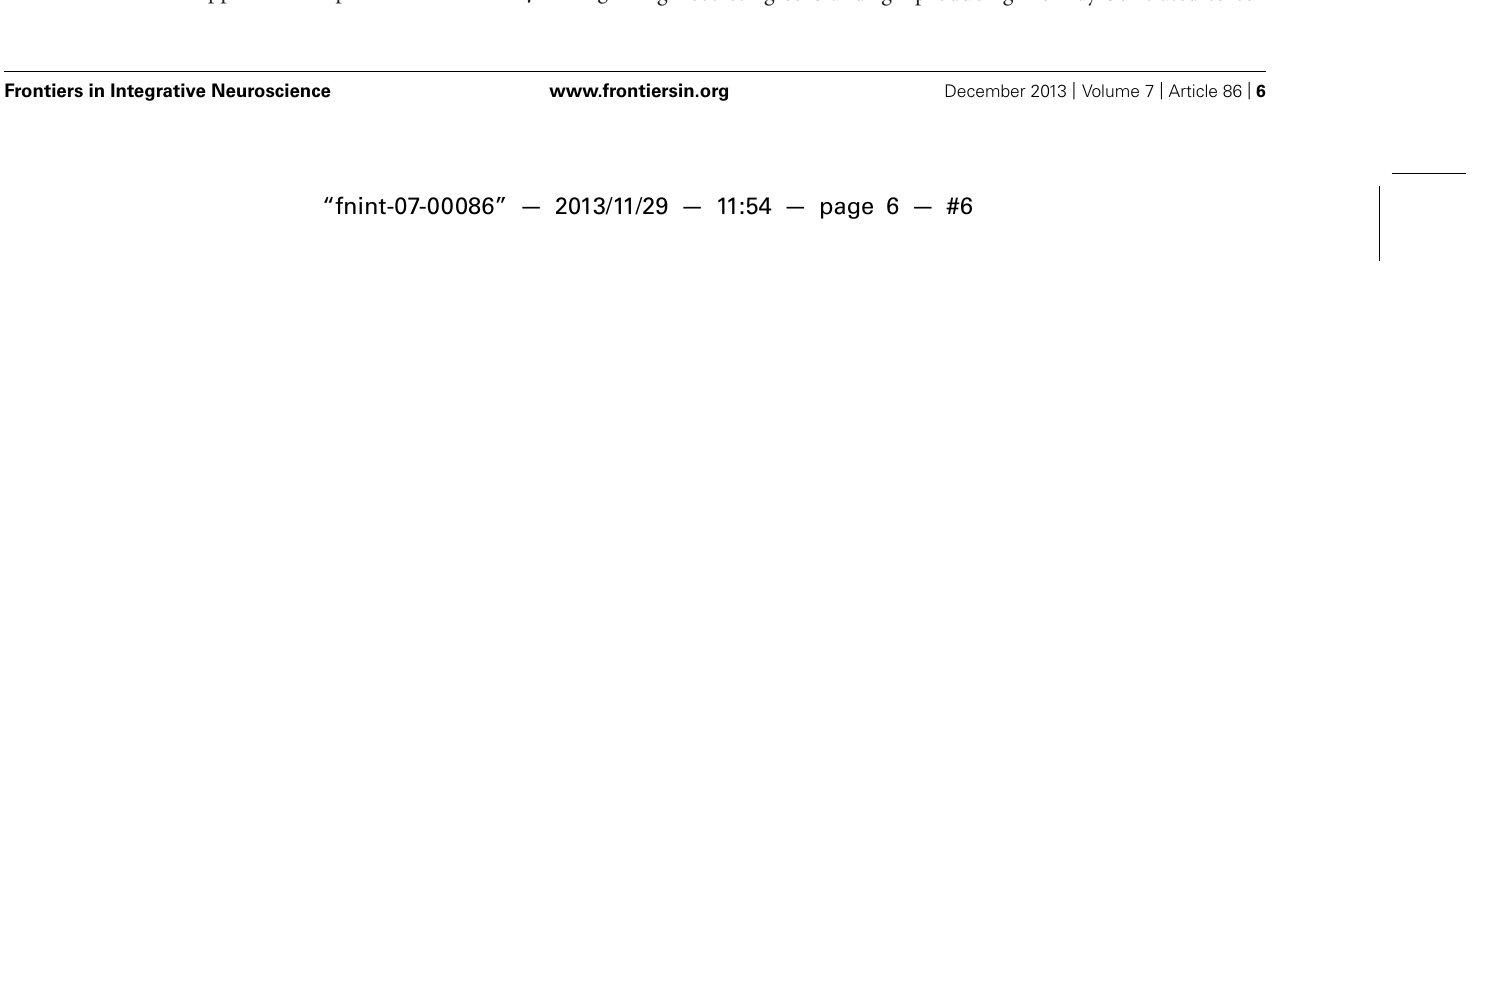
The former is then released to the gut lumen as secretory component (SC) bound to dIgA to yield secretory IgA (SIgA). SIgA and SC secreted into the mucus layer prevent the direct adhesion to the epithelium of pathogenic agents, which are eventually cleared from the lumen. Apart from enterocytes, other cell components of the gut epithelium include enterochromaffin cells with granules of neurotransmitters, Paneth cells with granules containing defensins and lysozyme, and goblet cells with mucin granules and